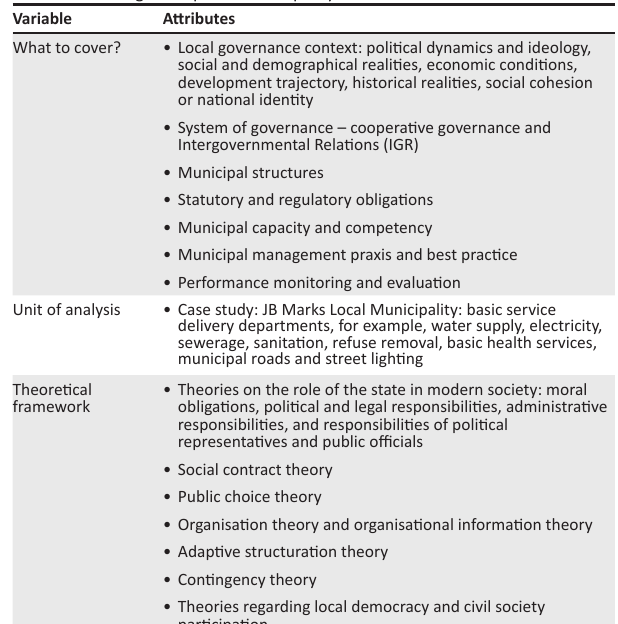
TABLE 2: Framing concept 2 – Municipality.